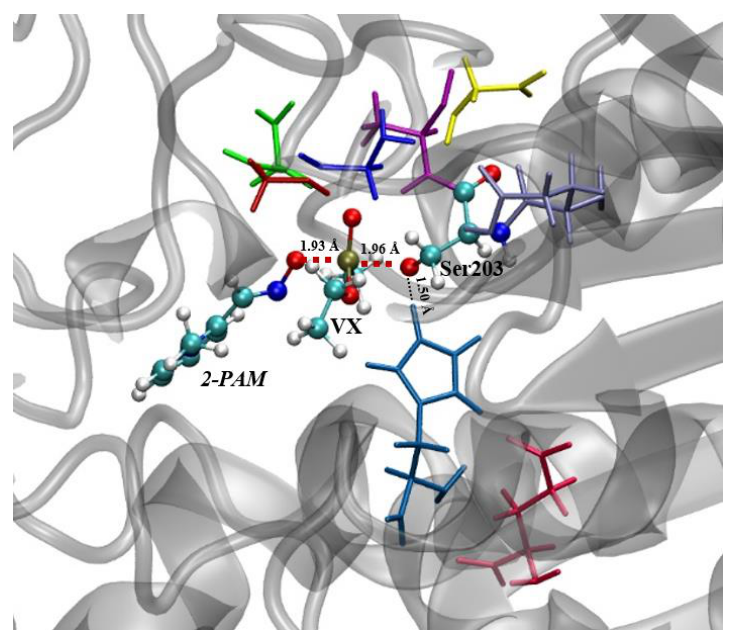
Figure 4. TS structure (QM system = coloured atoms) for the reactivation reaction of VX-inhibited Hss AChE by deprotonated 2-PAM.